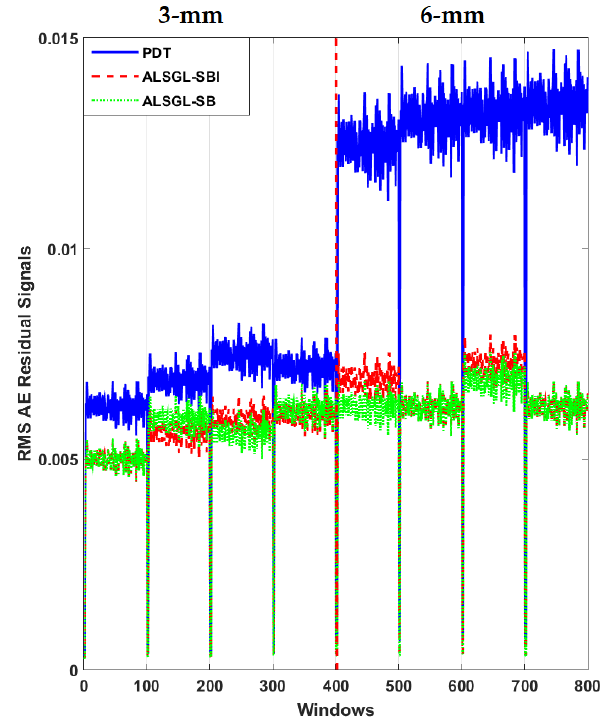
Figure 20. RMS of resampled AE residual signals for crack size (3 mm and 6 mm) diagnosis for inner–ball conditions using ALSGL-SB, ALSGL-SBI and PDT methods.